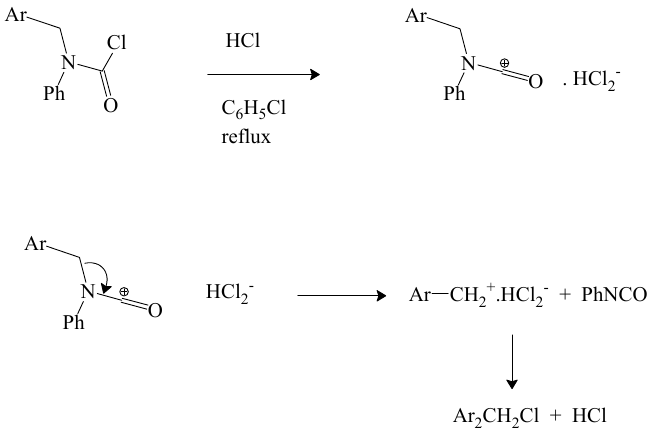
Scheme 2. Electrophilic catalysis by HCl.